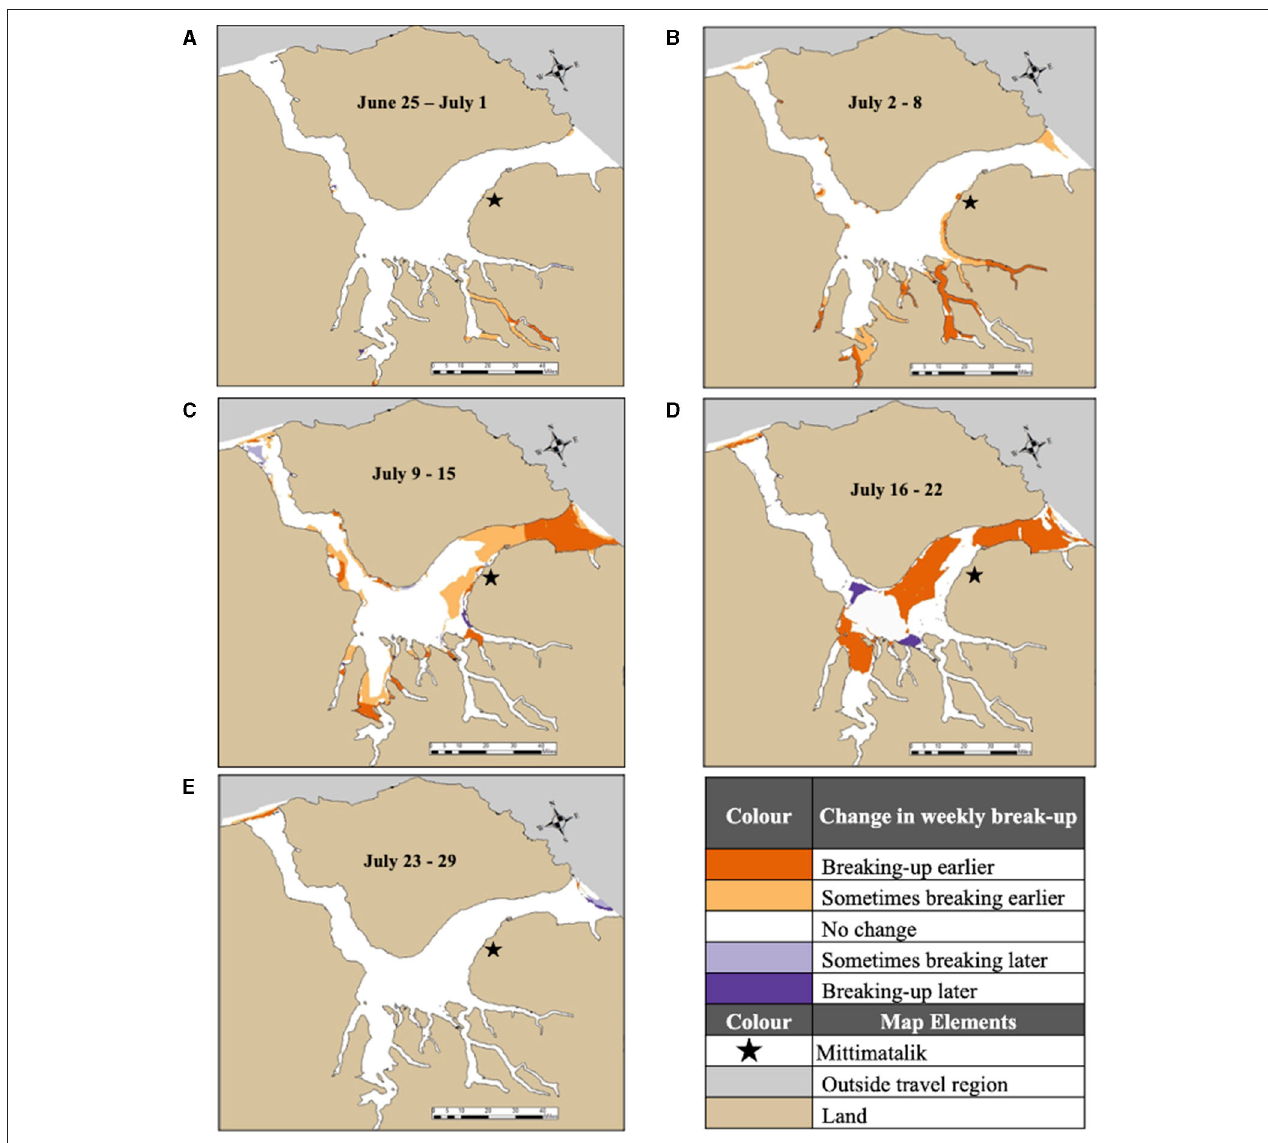
FIGURE 15 | Weekly difference maps showing areas where break-up is occurring earlier or later in the last 10 years (2010–2019). (A) Difference map, June 25–July 1. (B) Difference map, July 2–8. (C) Difference map, July 9–15. (D) Difference map, July 16–22. (E) Difference map, July